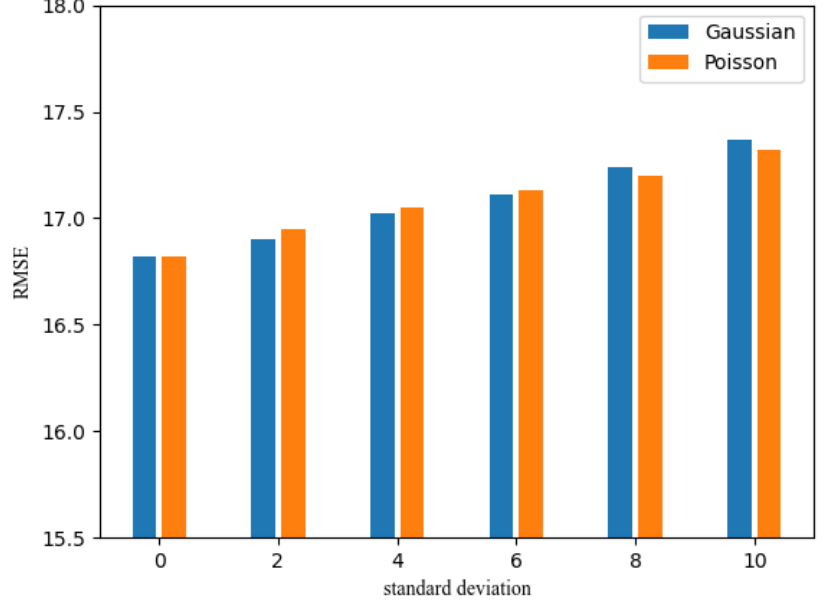
Figure 11. RMSE of TaxiBJ dataset under different intensities of Gaussian perturbation. The x -axis of Figure 11 represents the standard deviation of the Gaussian and Poisson perturbations, with larger values indicating stronger noise interference, and 0 representing no noise. We observed that the model’s accuracy remained stable under various intensities of noise. Even when adding Gaussian perturbation or Poisson perturbation with a